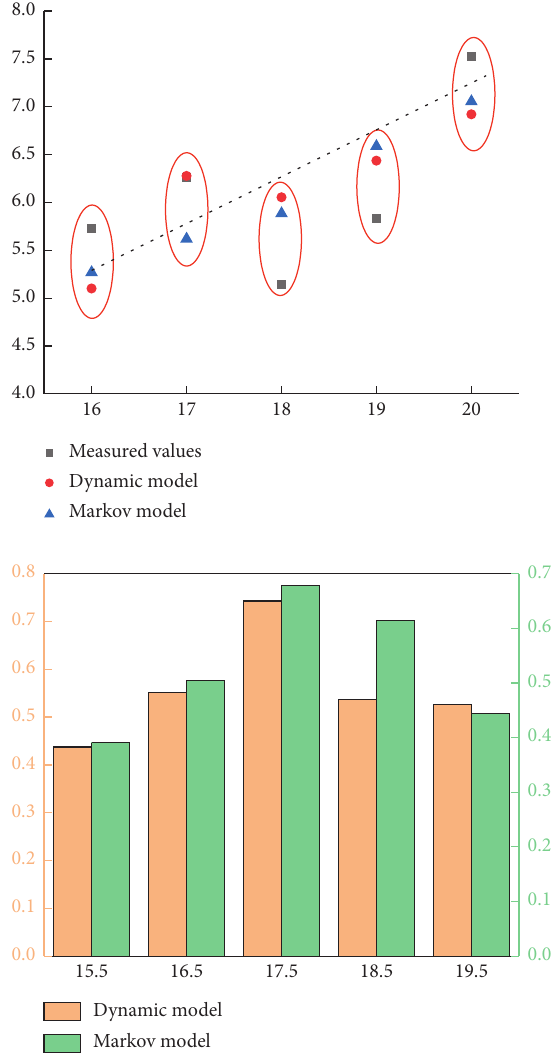
Figure 9: Model processing